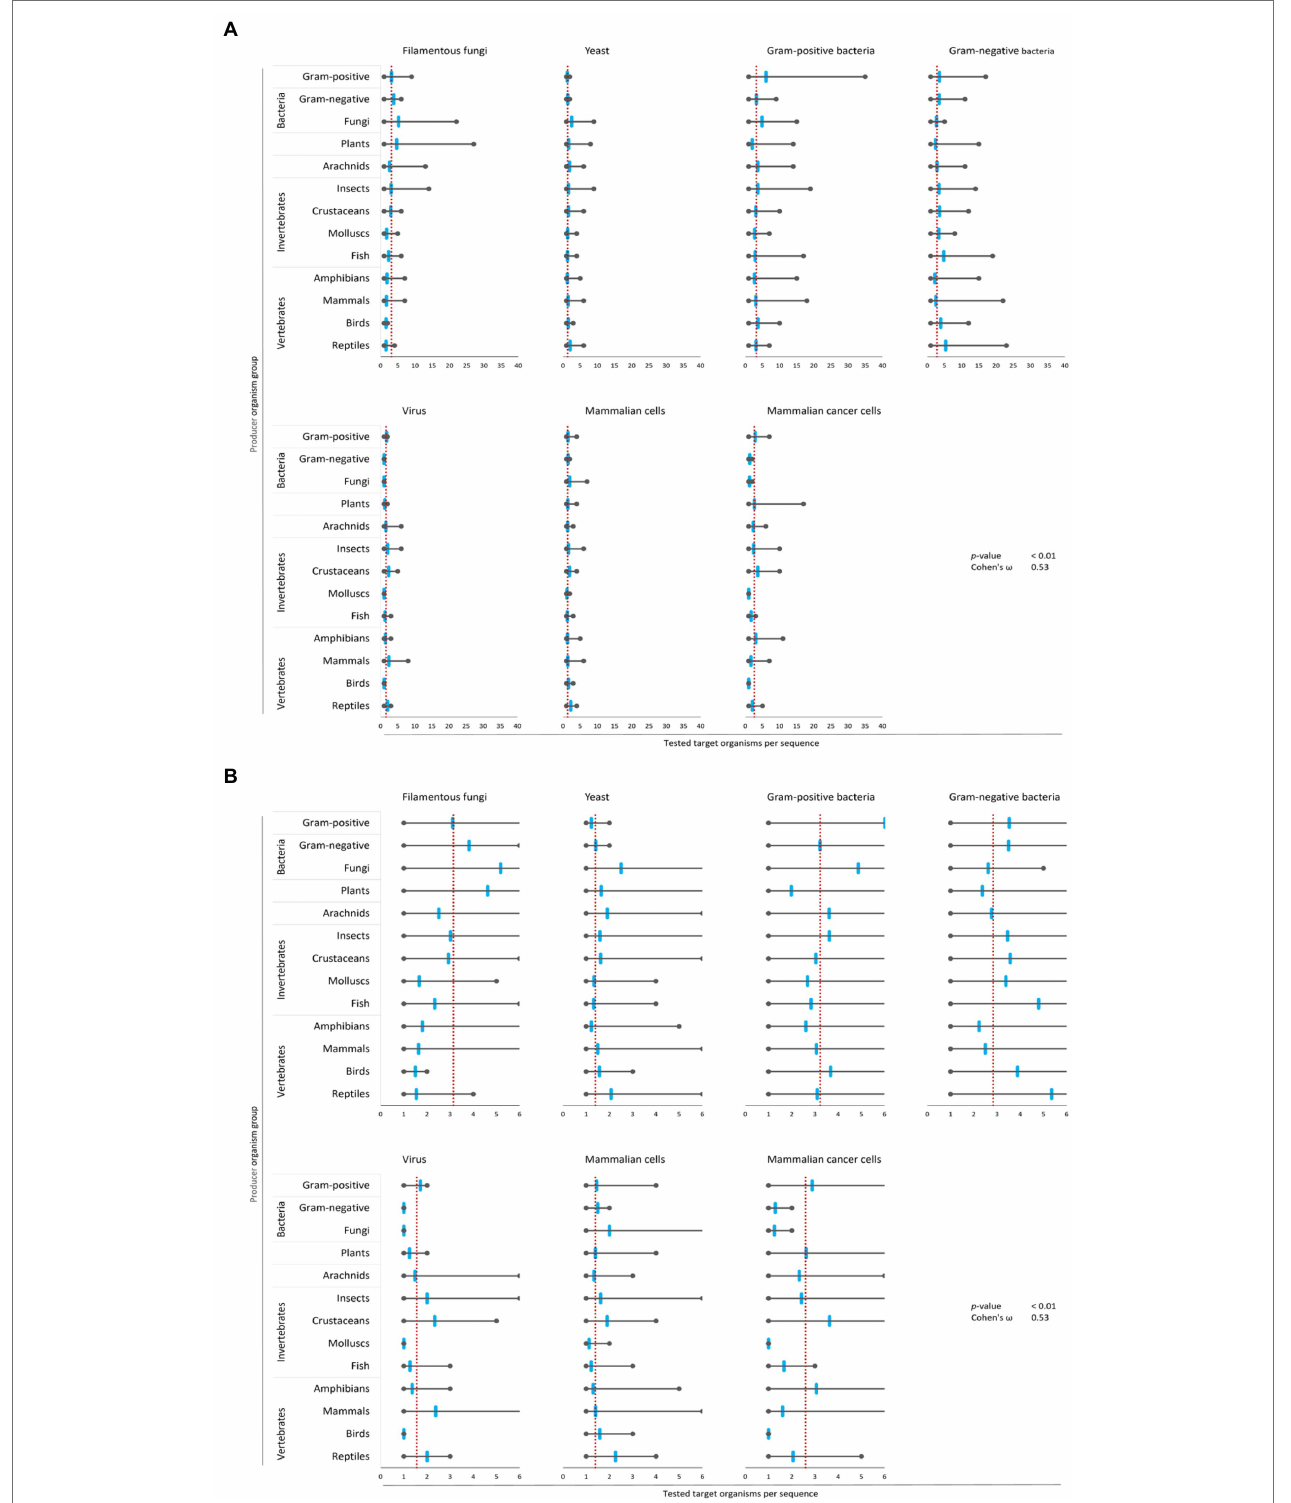
FIGURE 4 | Bias of AMP activity testing. Data were mined from the APD, DRAMP and DBAASP databases and subsequently processed. The average of tested species for each target group was determined (red dotted line). Additionally, the mean (blue mark), the maximum (right grey mark) and the minimum (left grey mark) of tested species for each target organism and producing organism group were calculated. For better assessment of the displayed data, the diagrams of (A) were magnified and are displayed in (B) . The association and its magnitude were determined by the p -value and the Cohen’s ω ,